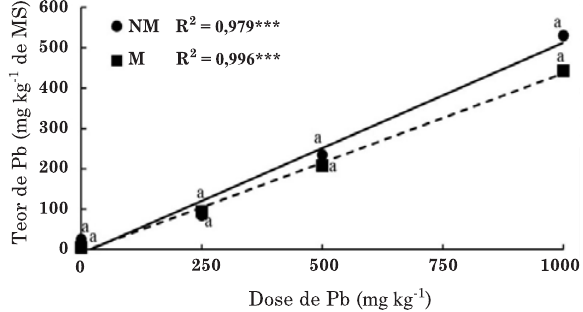
Figura 11. Teor de Pb em parte aérea de plantas de Stizolobium aterrimum micorrizadas (M – linha